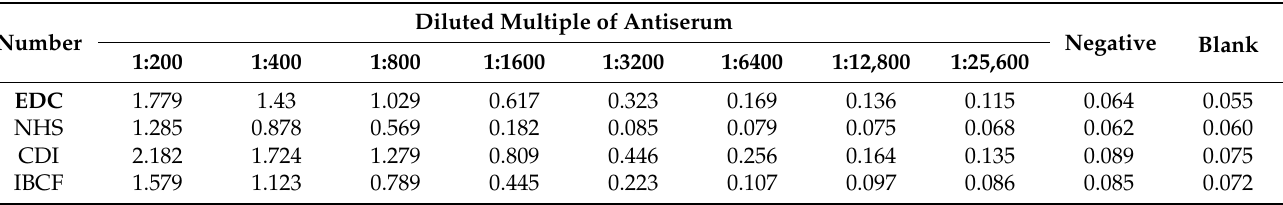
Table 1. The titres determination of DON pAb of four mice.